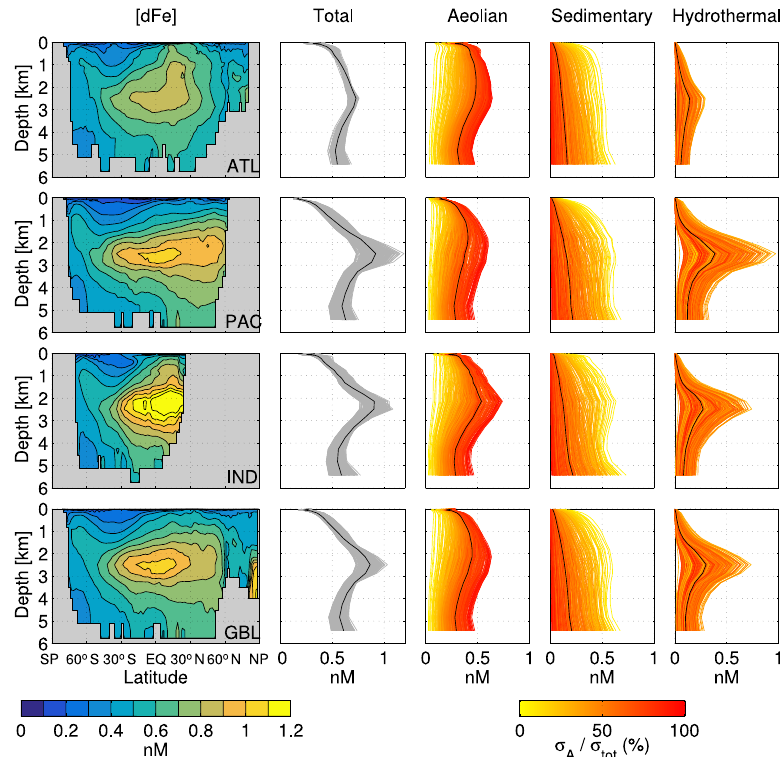
Figure 6. Estimates of the dFe concentration in each basin (ATL, PAC, IND) and globally (GBL). The zonal averages in latitude-depth space on the left show the total dFe field of our typical state estimate. The corresponding horizontally averaged profiles of total dFe are shown in grey for each family member and in black for the typical state estimate. The three columns of plots on the right show the source-partitioned dFe profiles of each family member. The individual source-partitioned profiles are color coded according to the percent contribution of the aeolian source to the total iron source, with our typical state estimate shown in